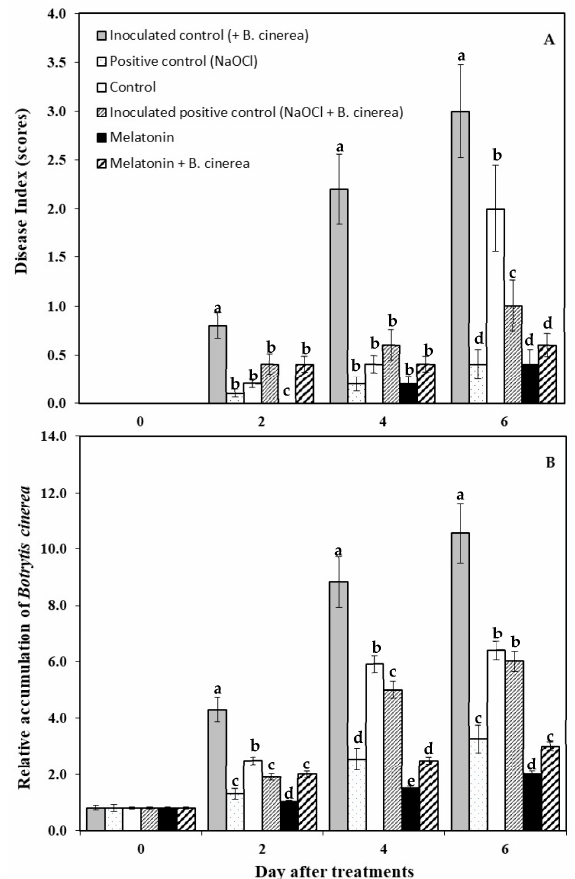
Figure 3. Disease index ( A ) and biomass of Botrytis cinerea were measured using real time PCR ( B ) in strawberry fruits treated with exogenous melatonin and inoculated with and without Botrytis cinerea , and stored at room temperature (25 ± 2 ◦ C, 80–85% RH) for 6 days. Values are the average of three replicates ± SD. Different letters indicate significant differences according to Duncan’s multiple range test ( p <